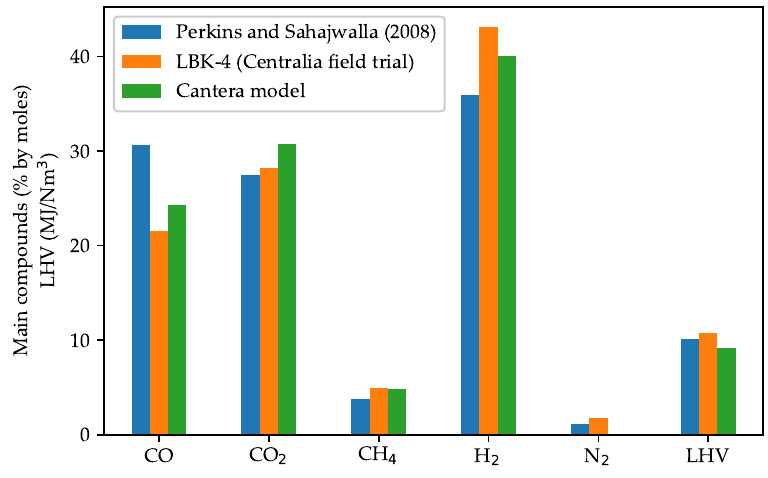
Figure 5. Comparison of our simulation results on the Centralia Large Block experiment LBK-4 (T = 630 ◦ C, p = 0.125 MPa, stoichiometric ratio = 0.3) against field data [58] and the kinetic modeling results of Perkins and Sahajwalla [53].